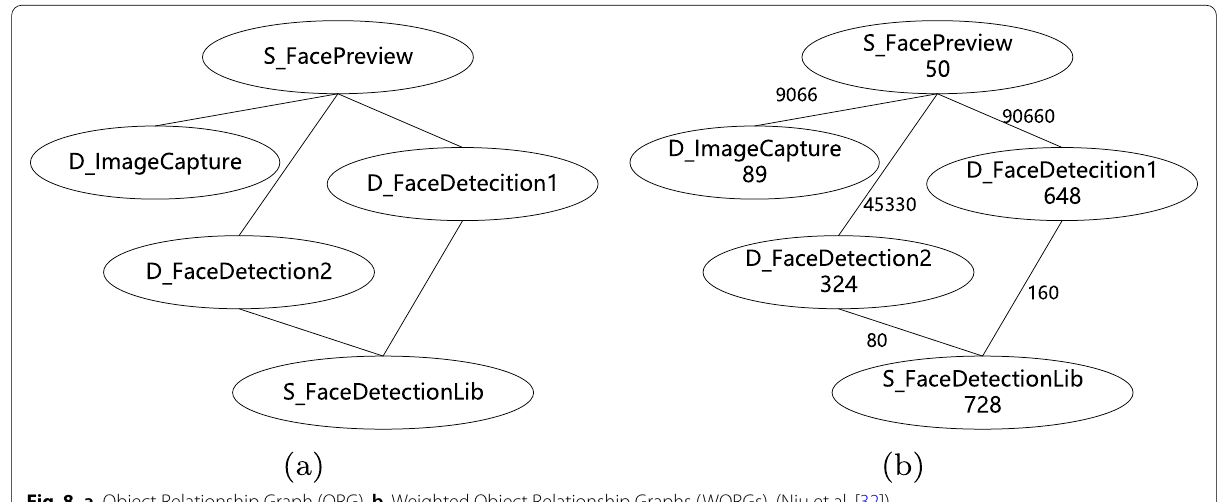
Fig. 8 a Object Relationship Graph (ORG). b Weighted Object Relationship Graphs (WORGs). (Niu et al.